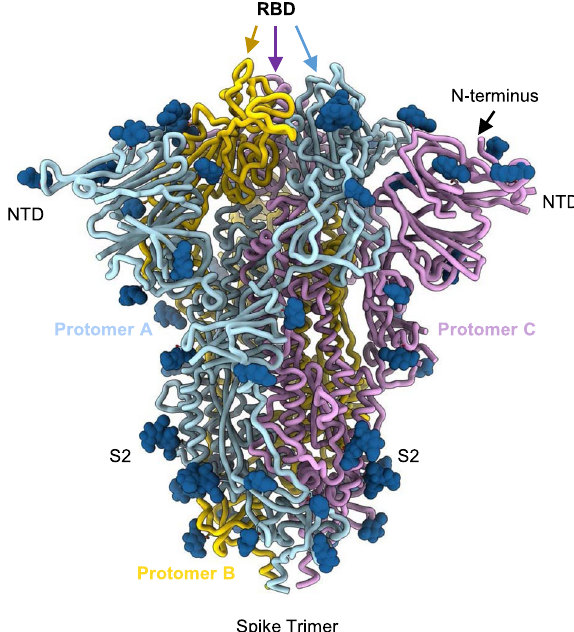
Fig. 1 Structure of the SARS-CoV-2 S-protein in the trimeric prefusion conformation. The structure of the S-protein trimer was modeled based on PDB 7LXY 37 . The three protomers (A, B, and C) are colored in cyan, yellow, and lilac, respectively. Structural components indicated include the NTD, the RBD, the N terminus, and the S2 domain.